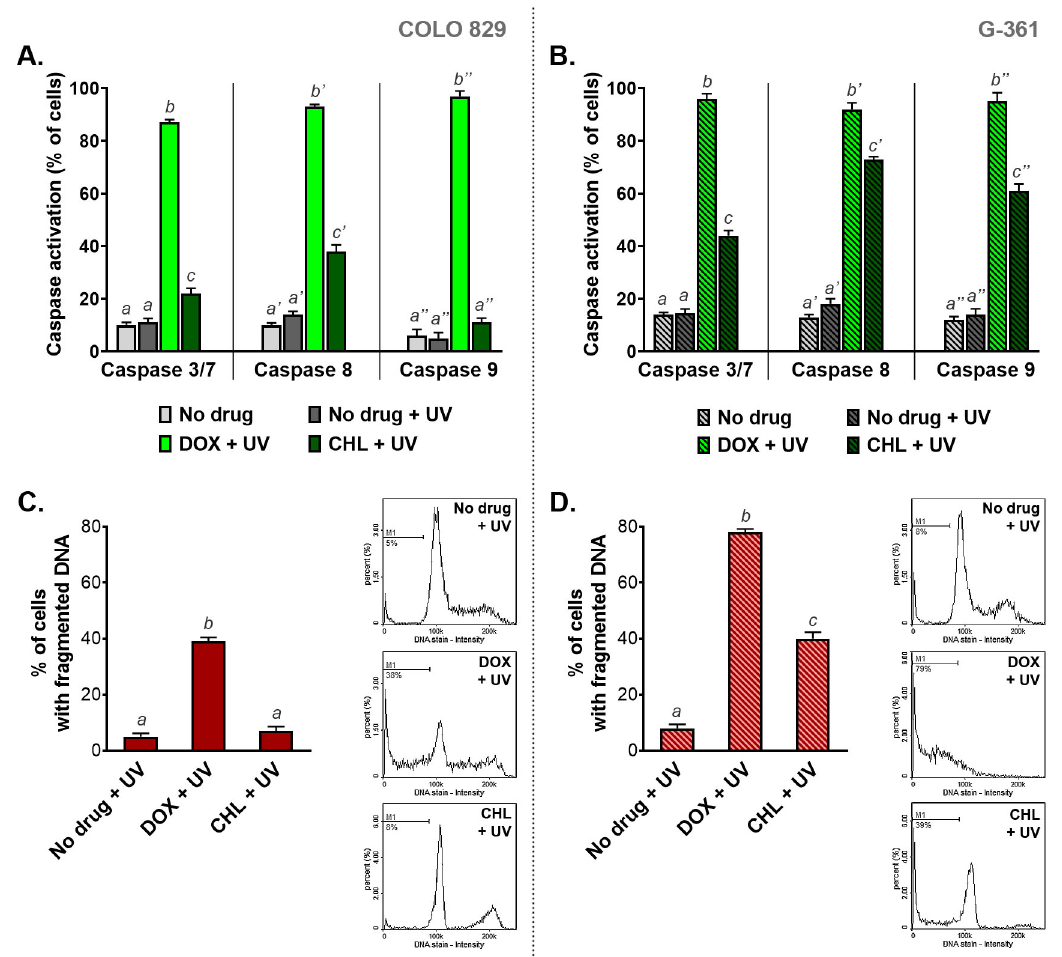
Figure 7. The analysis of caspase activation ( A , B ) and DNA fragmentation ( C , D ) in melanoma cells treated with doxycycline and chlortetracycline and irradiated with UVA. Bar graphs present mean values ± SD. Included histograms are representative results of cytometric analysis of DNA fragmentation. Using different letters to show statistical